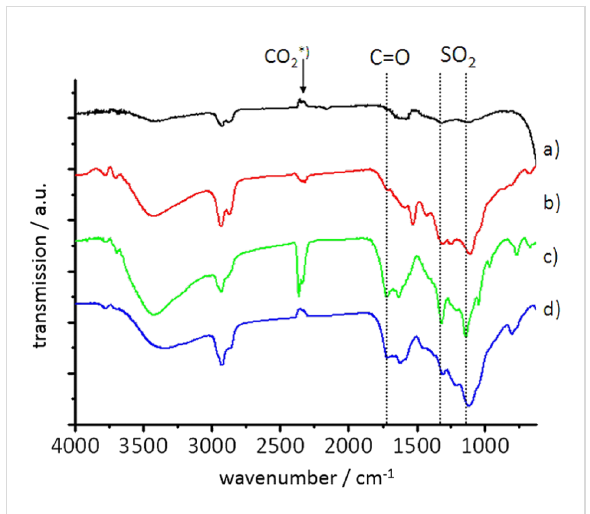
Figure 2: FTIR spectra (left) of compounds 2 (a), 9 (b), 10 (c) and 11 (d). The formation of the sulfone groups in 10 and the reduction of signal intensity for 11 are clearly visible. In the spectrum of 10 and 11 the carbonyl signals generated by the side reaction of MCPBA with surface groups are marked with a dotted line (the CO 2 signal is due to ambient